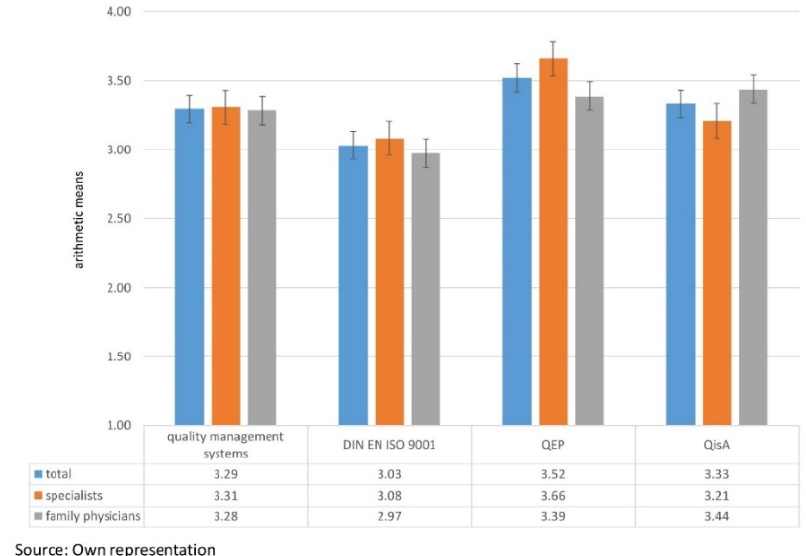
Figure 1. Average scores of quality management systems. Figure 1 shows the average scores of quality management systems. The questionnaires featured scores from one to four, with four (very good) being the highest and one the lowest (very poor) score.